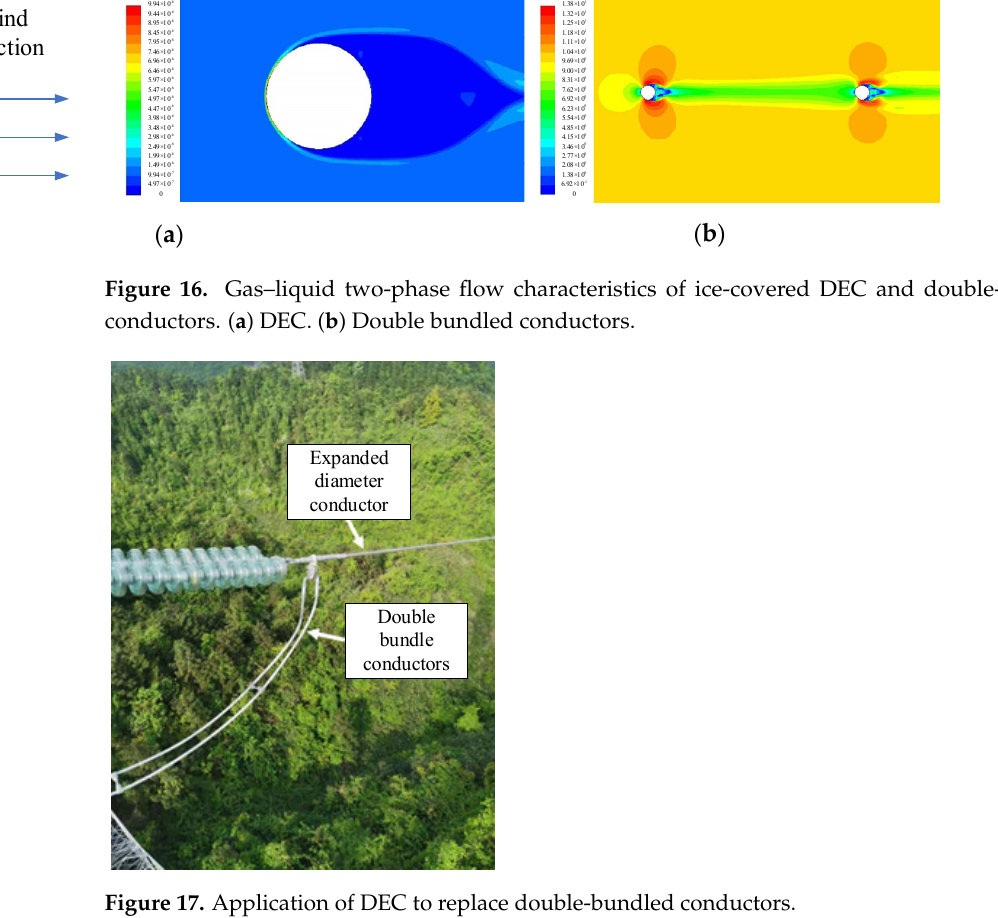
( h ) Figure 15. Icing picture of different diameter aluminum tubes and quad bundled conductors: ( a ) 40 mm, ( b ) 50 mm, ( c ) 60 mm, ( d ) 70 mm, ( e ) 80 mm, ( f ) 90 mm, ( g ) 100 mm, ( h ) quad bundled conduc-